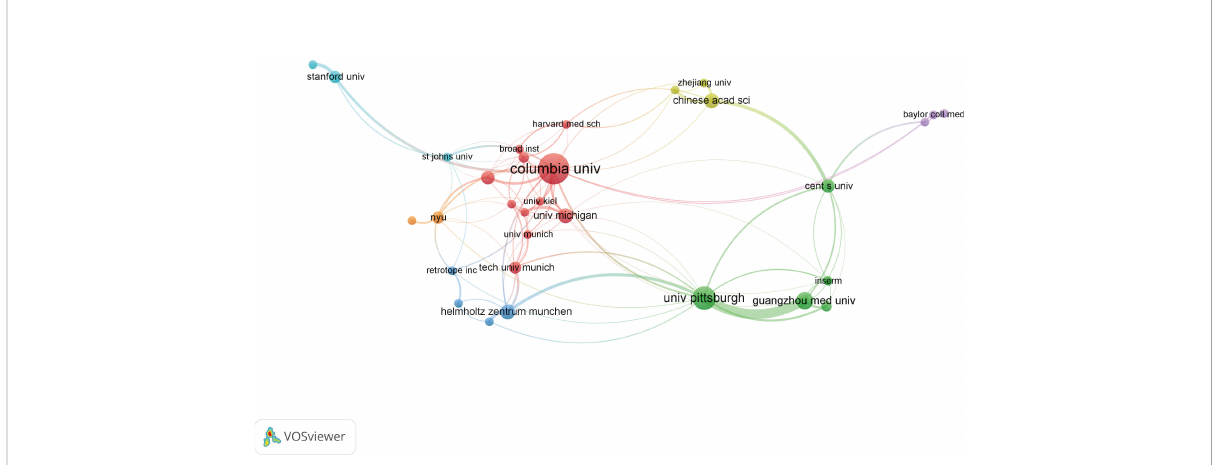
FIGURE 4 Network visualization map of institution co-authorship